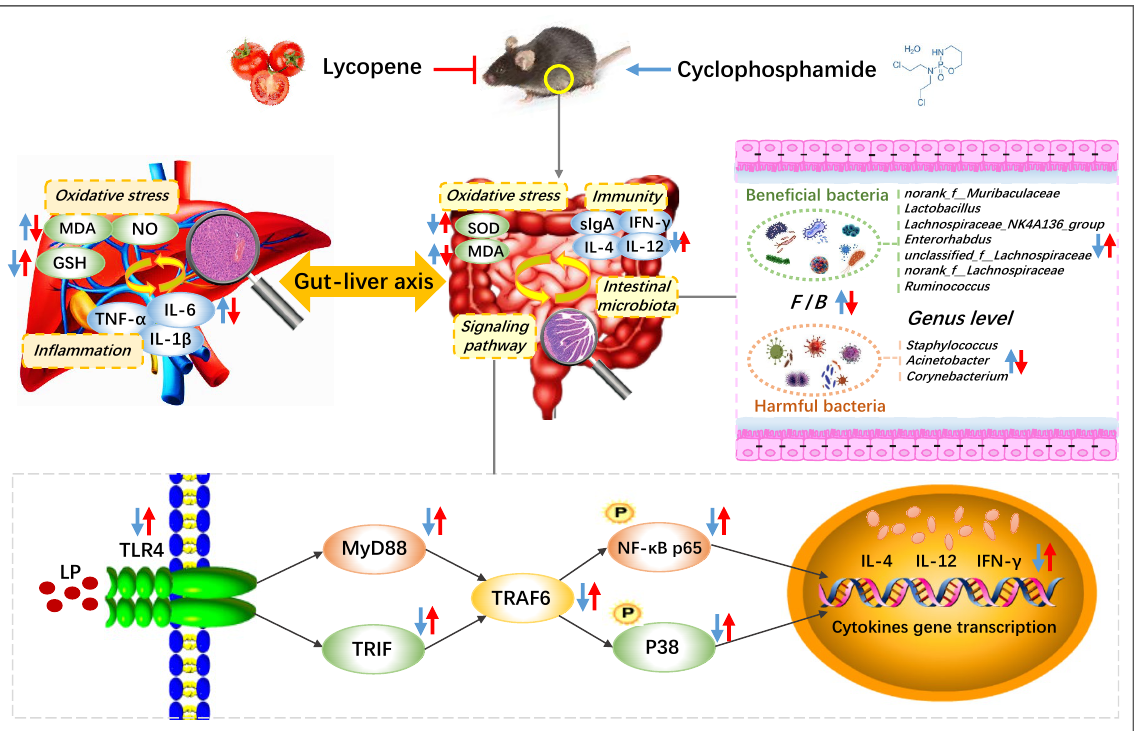
Figure 6. Preventive mechanism of lycopene on intestinal toxicity caused by cyclophosphamide chemotherapy in mice by regulating TLR4-MyD88/TRIF-TRAF6 signaling pathway and gut-liver axis. The blue arrows show the effect of CYC treatment, and the red arrows show the effect of LP treatment on CYC mice. ↑ : up-regulation; ↓ : down-regulation.